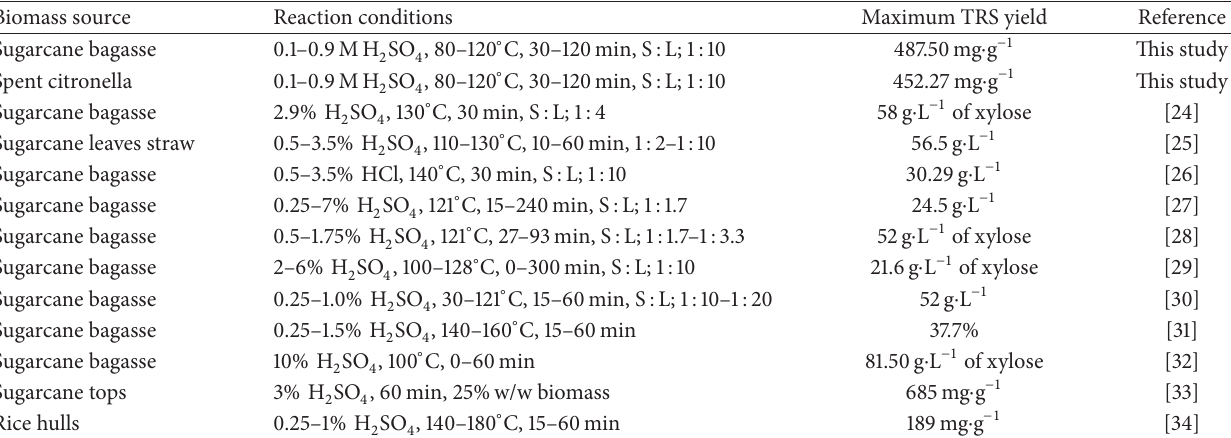
Table 2: Comparison of the present study in production of total TRS with reported